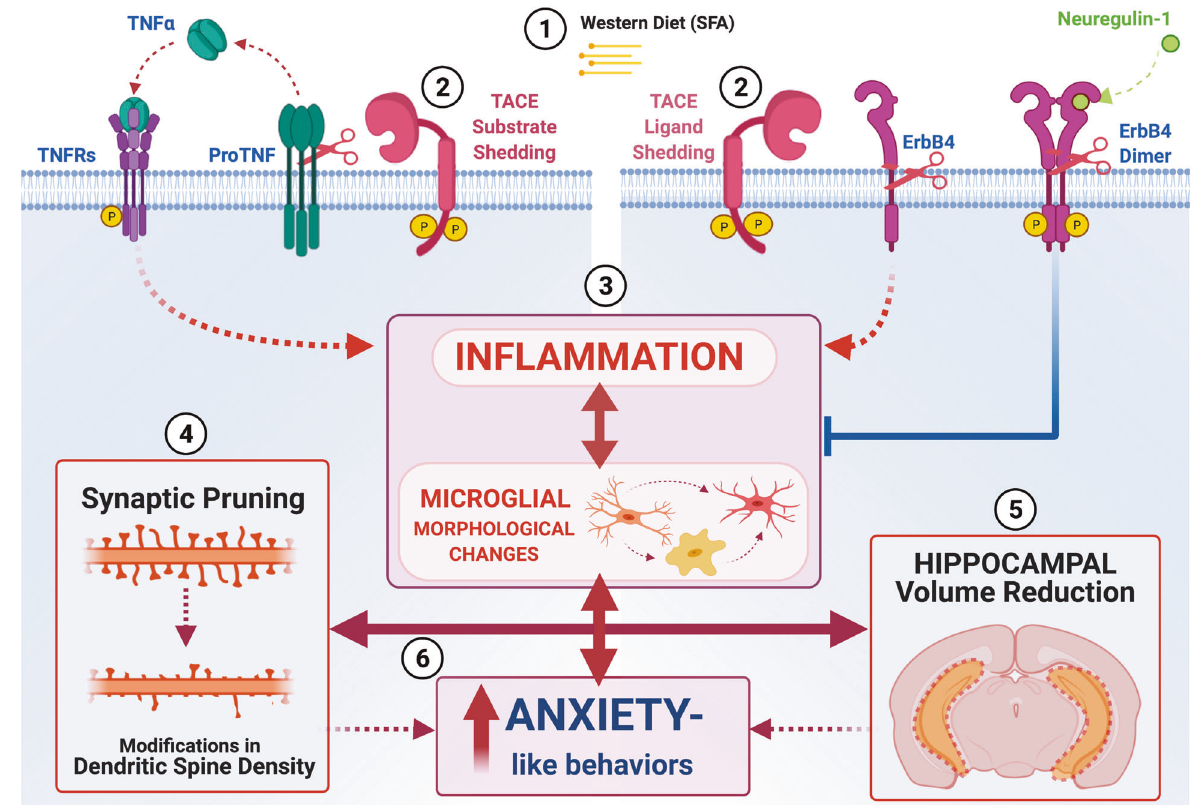
Fig. 8 Working model unifying neurodevelopmental and neuroin fl ammatory hypotheses implicated in obesity-mediated hippocampal dysfunction. 1 It is plausible that exposure to obesogenic diets rich in saturated fatty acids (SFAs) increase TACE/ADAM17 sheddase expression and activities, (2) leading to dysregulation of neuroin fl ammatory (e.g., tumor necrosis factor alfa, TNF- α ) and neurodevelopmental (ErbB4) mediators. (3) TNF receptor (TNFR) activation and prolonged ErbB4 cleavage tip the in fl ammatory balance to a pro-in fl ammatory state associated with microglial activation. (4) Neuroin fl ammation and microglial activation promote synaptic pruning and remodeling. (5) Disruption in microglia-synapse interactions contributes to synapse loss, dysfunction, and, consequently, hippocampal volume atrophy. (6) In summary, evidence in this study supports the conclusion that microglia respond to trophic factors and secrete cytokines, which are critical for normative synaptic plasticity in the maturing brain [137, 138]. Our data suggest that an imbalance in the levels of cytokines and neurotrophic factors during early pre-obesity states can impair microglia, synaptic plasticity, which may result in anxiety. Although our analyses focused on microglia and provided limited directionality of the effects, this dataset provides a rich resource for identifying meaningful synaptic targets in response to an obesogenic